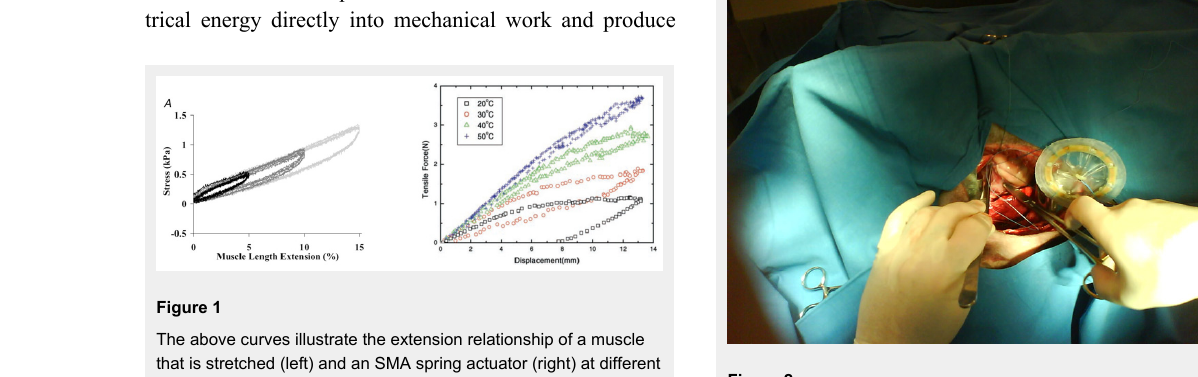
Animal implant of the Atripump. The concave part is assumed to touch atrium’s epicardium. When ON, the dome reduces its depth pushing down the atrial wall. When OFF, the dome returns to its rest position allowing atrial